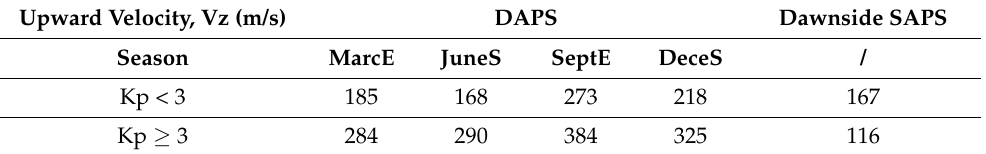
Table 3. The mean upflow velocities (Vz) at the latitudes where the DAPS and dawnside SAPS peak under two different Kp levels. The abbreviation MarcE denotes the March equinox, JuneS denotes the June solstice, SeptE denotes the September equinox, and DeceS denotes the December solstice.